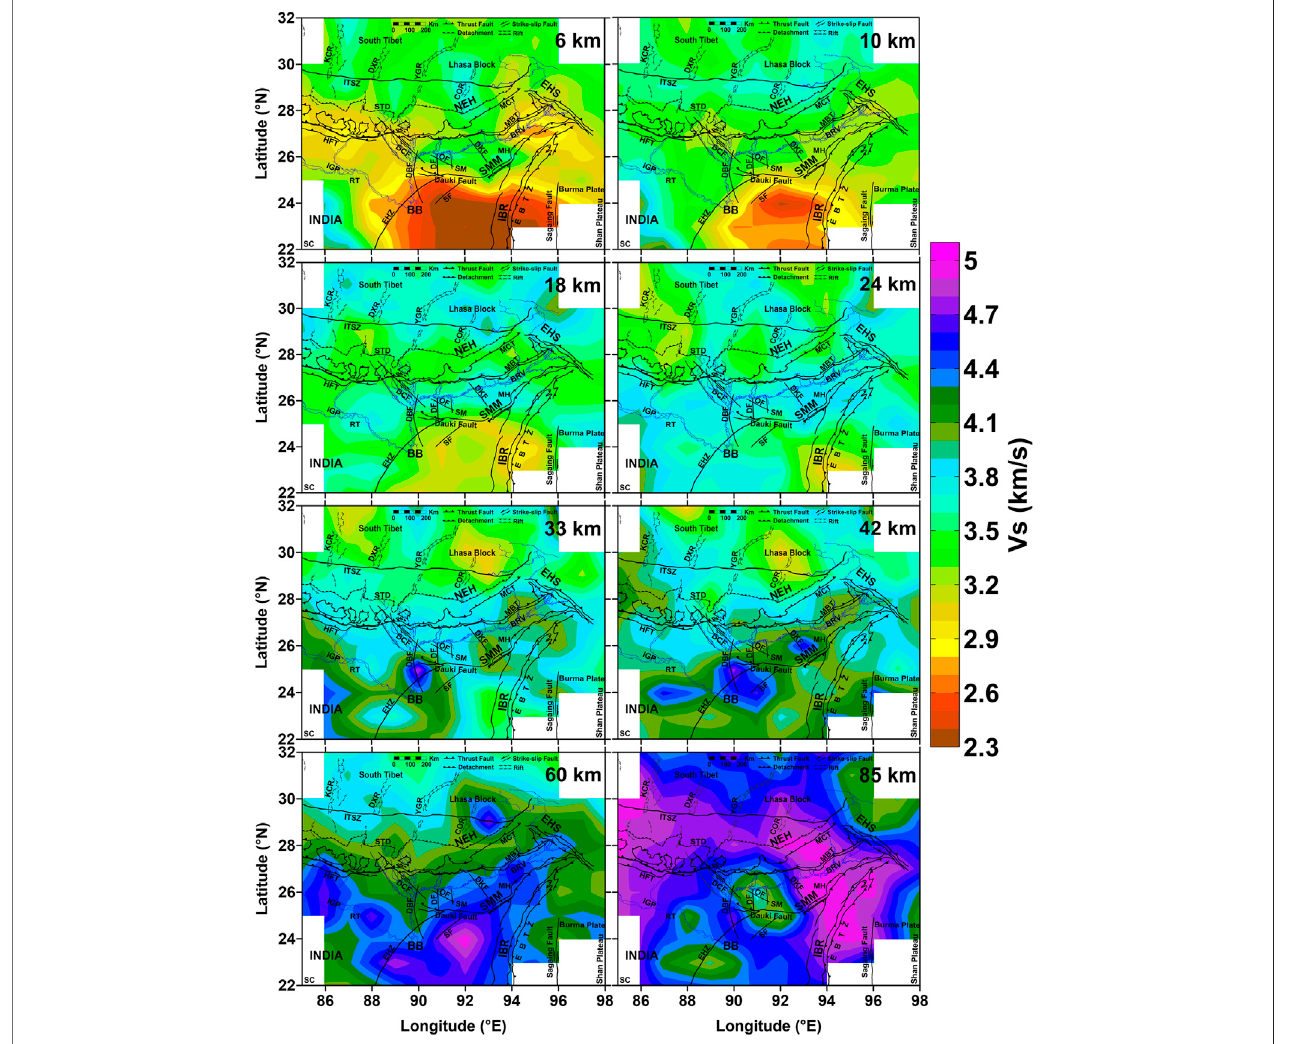
FIGURE 7 | Lateral variation of Vs at different depths. Abbreviations of tectonic features are as in Figure 1A .